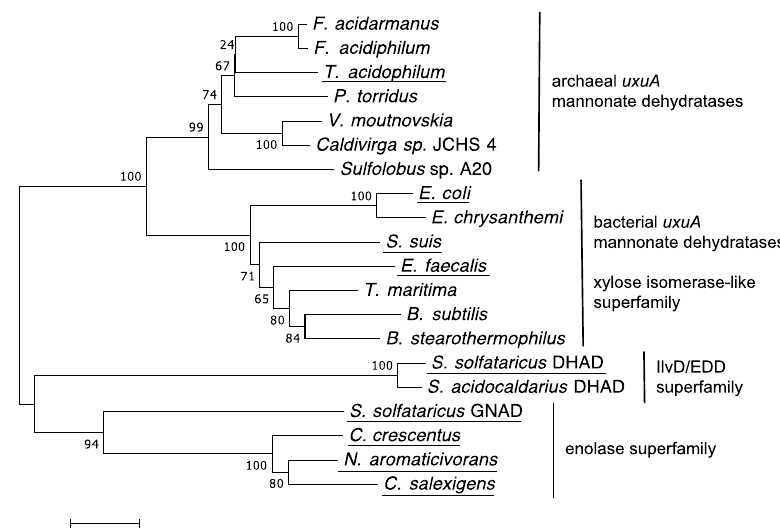
Figure 2. Phylogenetic relationship of different putative and confirmed dehydratases belonging to different enzyme families. Characterised enzymes are underlined. Evolutionary analyses were conducted in MEGA 7. 20 protein sequences were aligned using MUSCLE. The phylogenetic tree was inferred using the neighbour-joining method. The scale bar indicates an evolutionary distance of 0.20 nucleotide per position in the sequence. The number next to the nodes represent bootstrap confidence values estimated from 500 replicates. Protein sequences were retrieved from the Uniprot database and their entry codes are as follows. Ferroplasma acidarmanus : S0AL33, Ferroplasma acidiphilum : A0A1V0N416, Thermoplasma